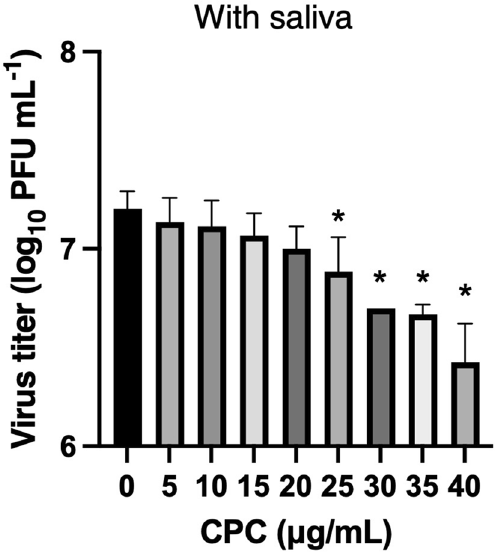
Figure 3. Antiviral efficacy of CPC against SARS-CoV-2 with saliva by plaque assay using Vero E6 cells expressing the TMPRSS2 gene (VeroE6/TMPRSS2). SARS-CoV-2 Wuhan strain was added in saliva and mixed with equal amount CPC. (* p <